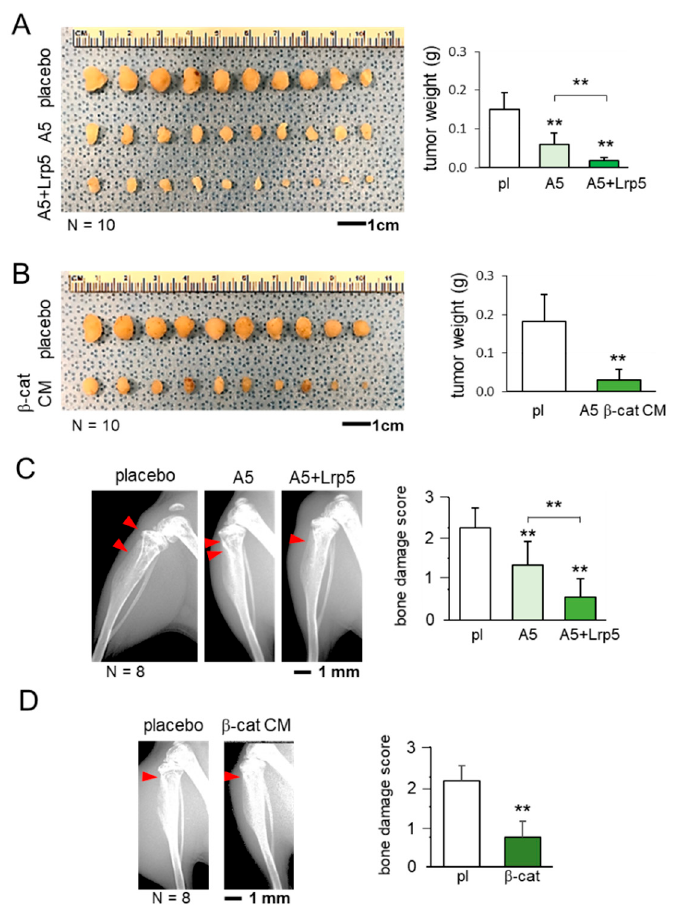
Figure 2. Suppression of the growth of mammary tumors and tumor-driven osteolysis by osteocytes and their conditioned medium. The double asterisk indicates p < 0.01. The error bar indicates a standard deviation. pl = placebo, and CM = conditioned medium. ( A ) Inhibition of the growth of mammary tumors by the co-injection of osteocytes and Lrp5-overexpressing osteocytes. ( B ) Reduction in the size of mammary tumors by the administration of b-catenin-overexpressing osteocyte-derived CM. ( C ) Prevention of bone loss in the proximal tibia by the co-injection of osteocytes and Lrp5-overexpressing osteocytes. The red arrowheads indicate the destructed area by tumor cells. ( D ) Protection of bone by the administration of b-catenin-overexpressing osteocyte-derived CM. The red arrowhead indicates the destructed area by tumor cells.